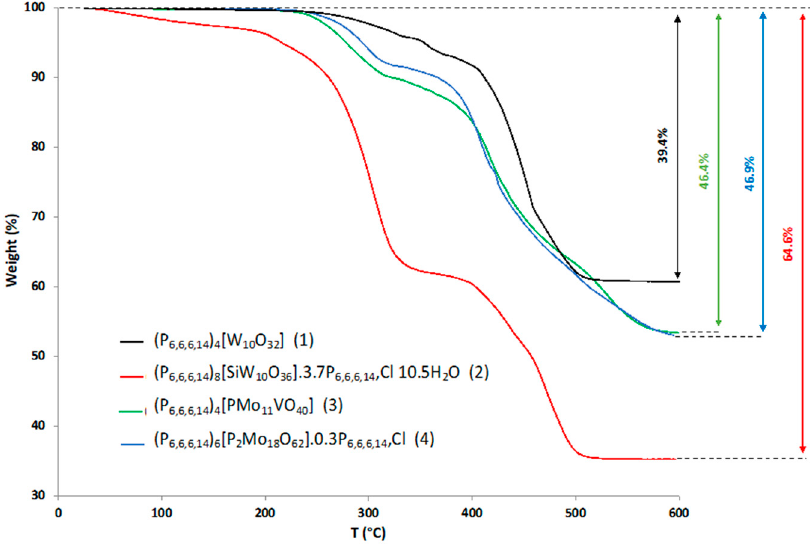
Figure 2. TGA curves recorded for compounds 1 – 4 under O 2 flow; heating rate of 5